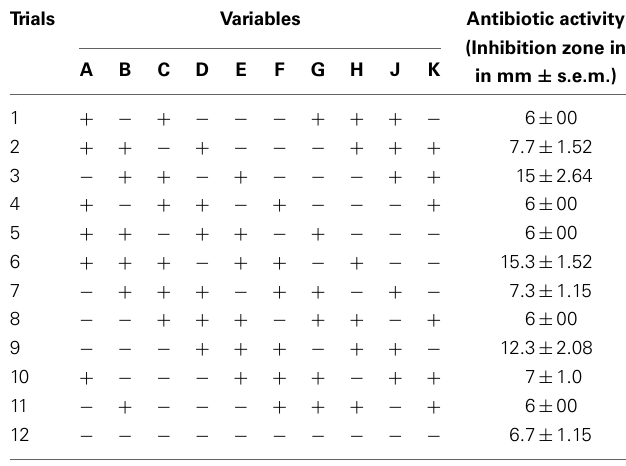
Table 2 | Plackett-Burman design and the experimental response obtained for JAJ13.